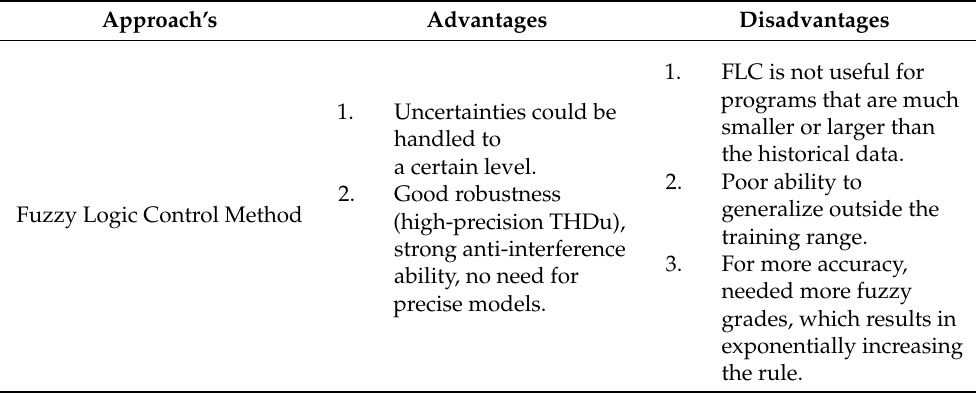
Table 8. Advantages and disadvantages of FLC and MPM control